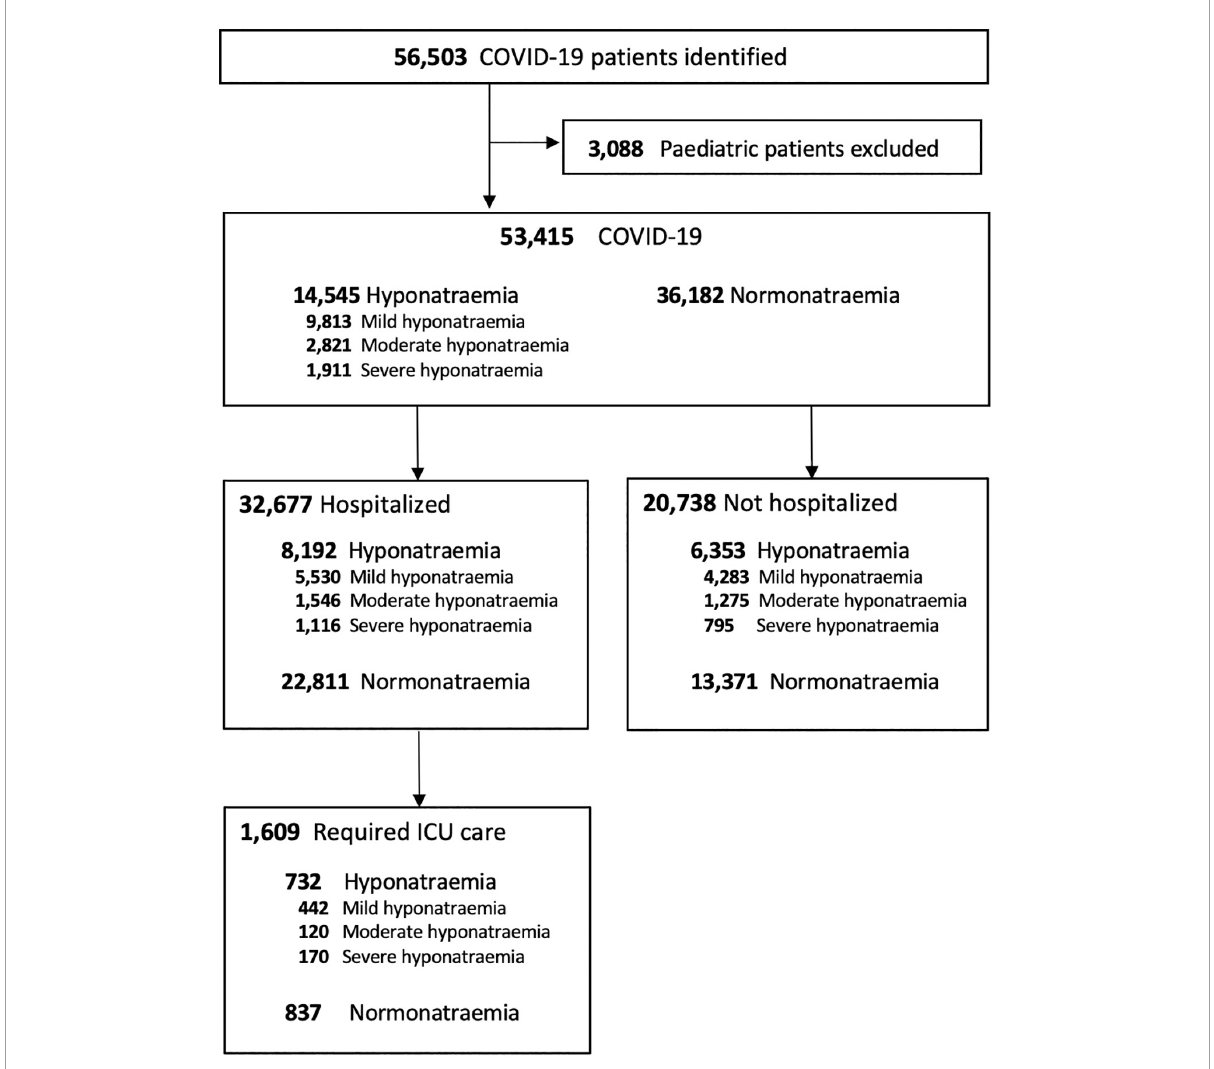
FIGURE1 Flow chart of COVID-19